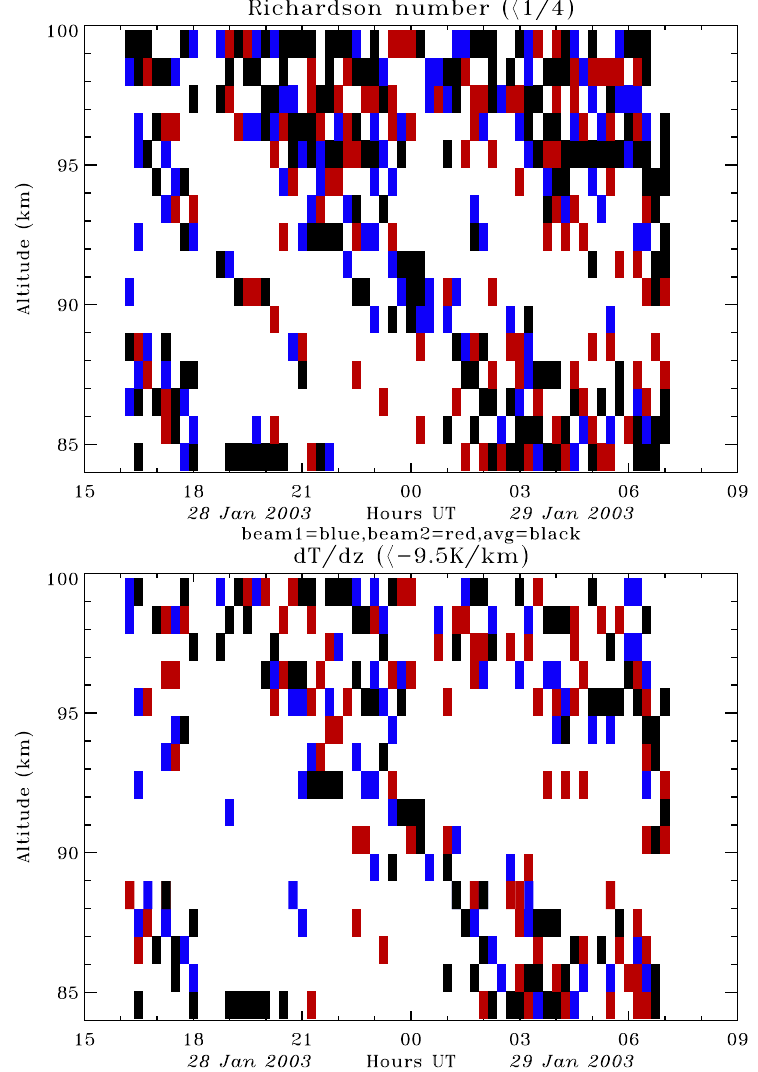
Fig. 4. Regions where the Richardson number is less than 1/4(top) or the lapse rate is greater than adiabatic (bottom) using the temperature gradient for beam 1 (blue), beam 2 (red), and the average of the two beams (black).